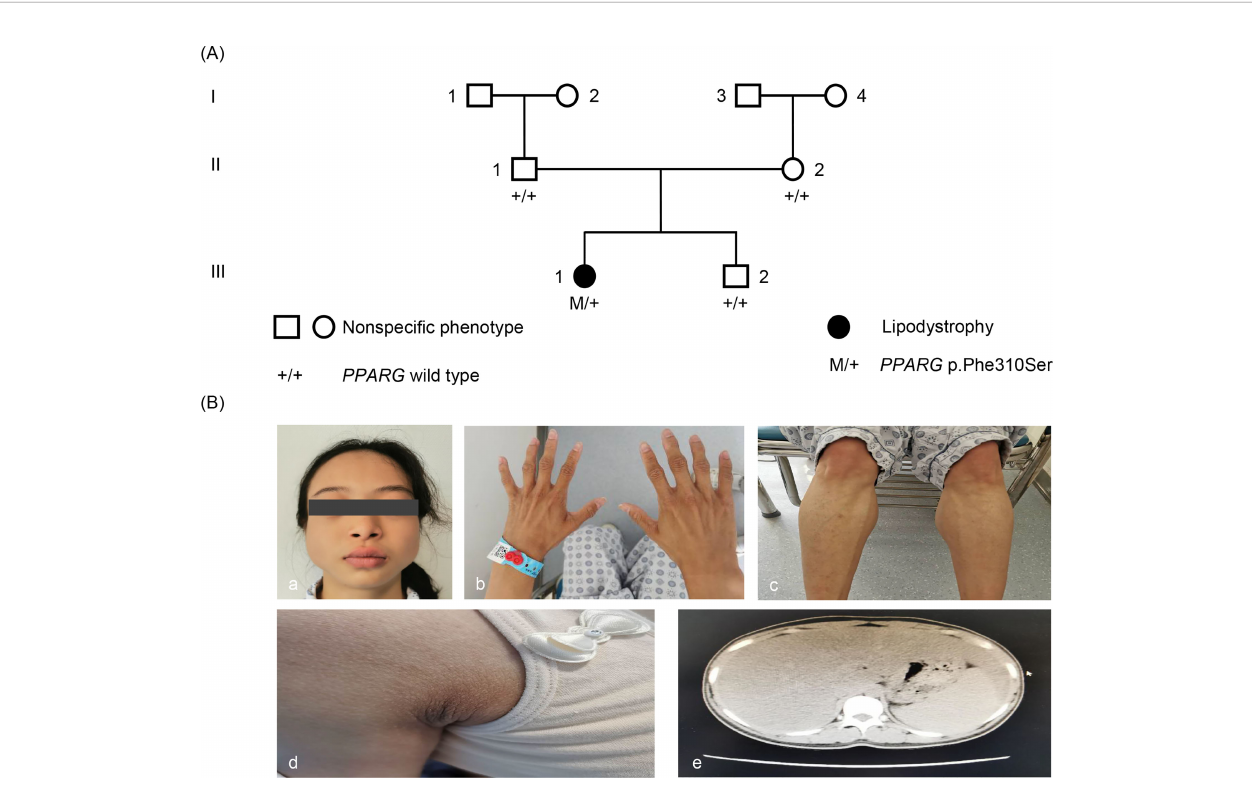
FIGURE 1 | Pedigree and phenotype. (A) Pedigree chart: The patient is indicated by dark symbols. The patient carrying the heterozygote mutation c.929T > C is marked by M/+. Tested family members without the mutation are marked by +/+ . (B) Phenotype: a, c, and d, the patient presented with loss of subcutaneous fat, especially in the face, hands, and lower limbs. b, Patient had acanthosis nigricans in axillaris. e, Abdominal CT showed liver and spleen enlargement and fatty